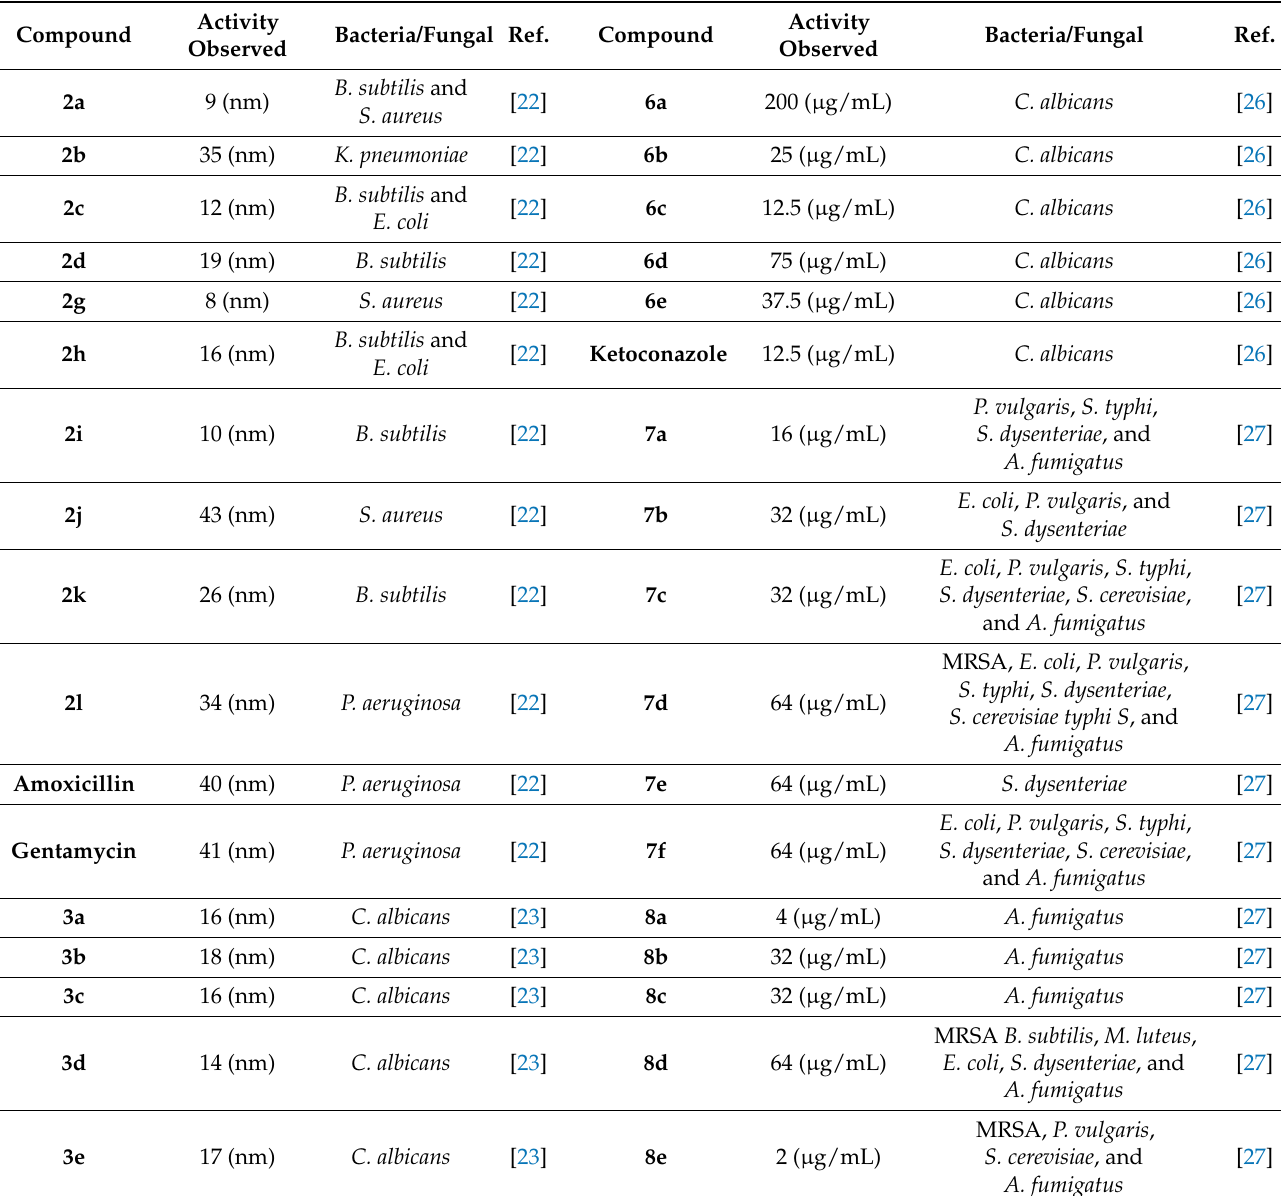
Table 1. Antimicrobial activity data of reported coumarin triazole derivatives. Bacteria/Fungal Ref. Compound